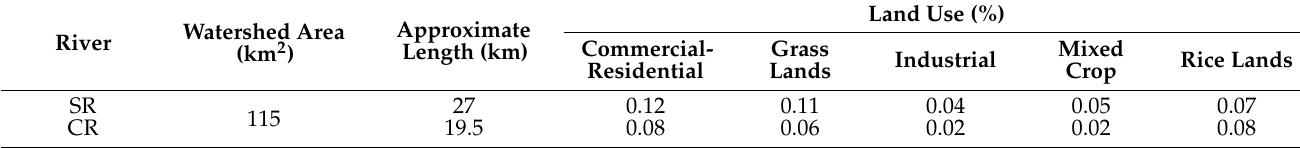
Table 1. Watershed area and land use in Santa Rosa (SR) and Cabuyao (CR) Rivers [45,46].